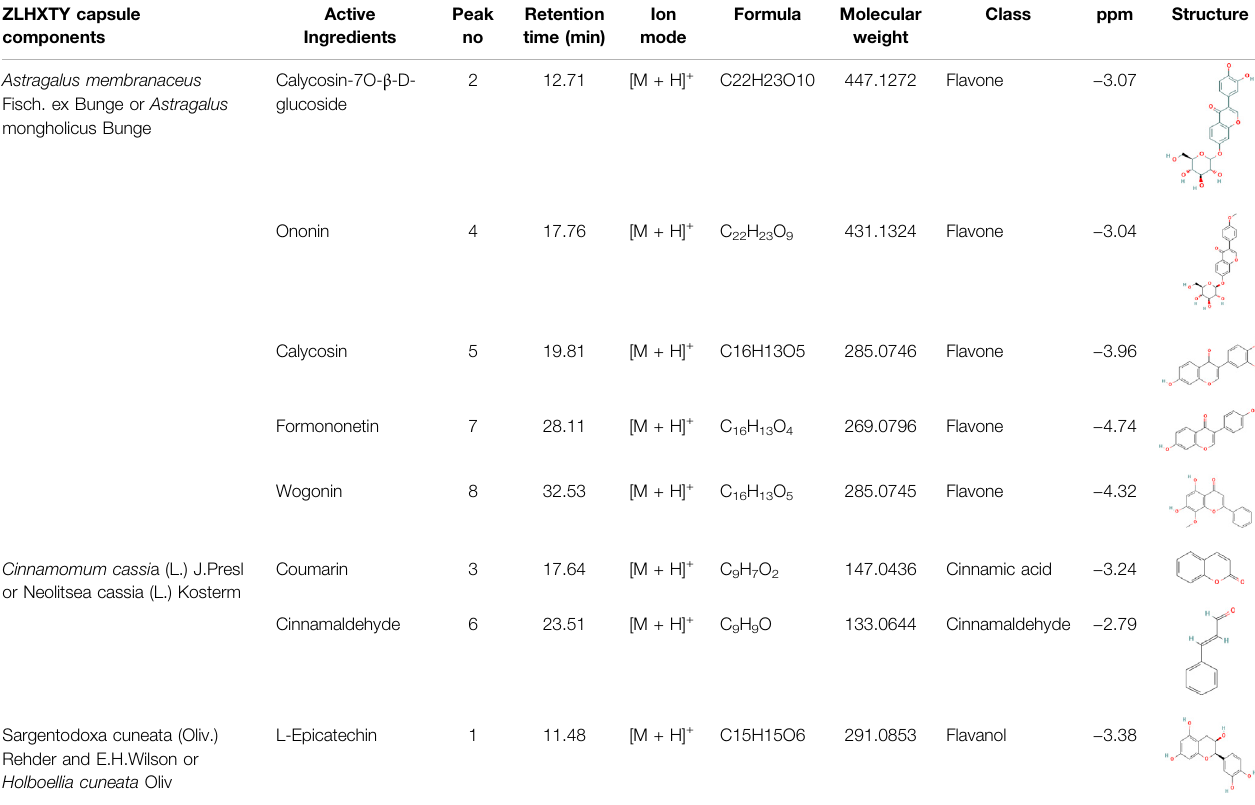
TABLE 6 | Representative compounds identi fi ed in UPLC-HR-MS analysis of ZLHXTY capsules. ZLHXTY capsule